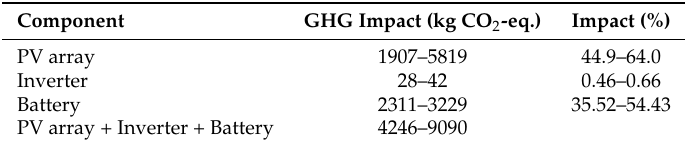
Table 6. The impact of the PV, battery and the inverter components.